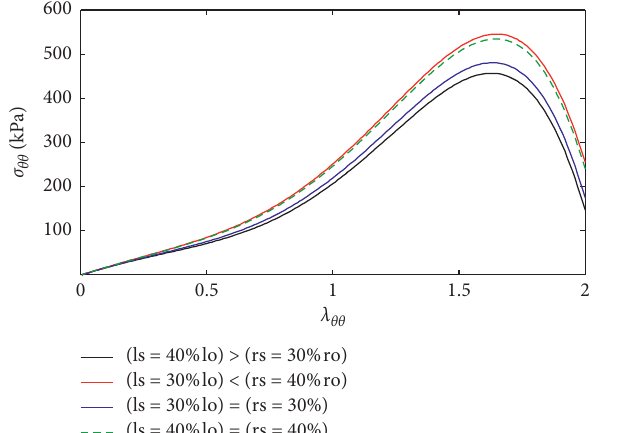
Figure 7: Comparative study of the deposition of plaque on the circumferential stress.